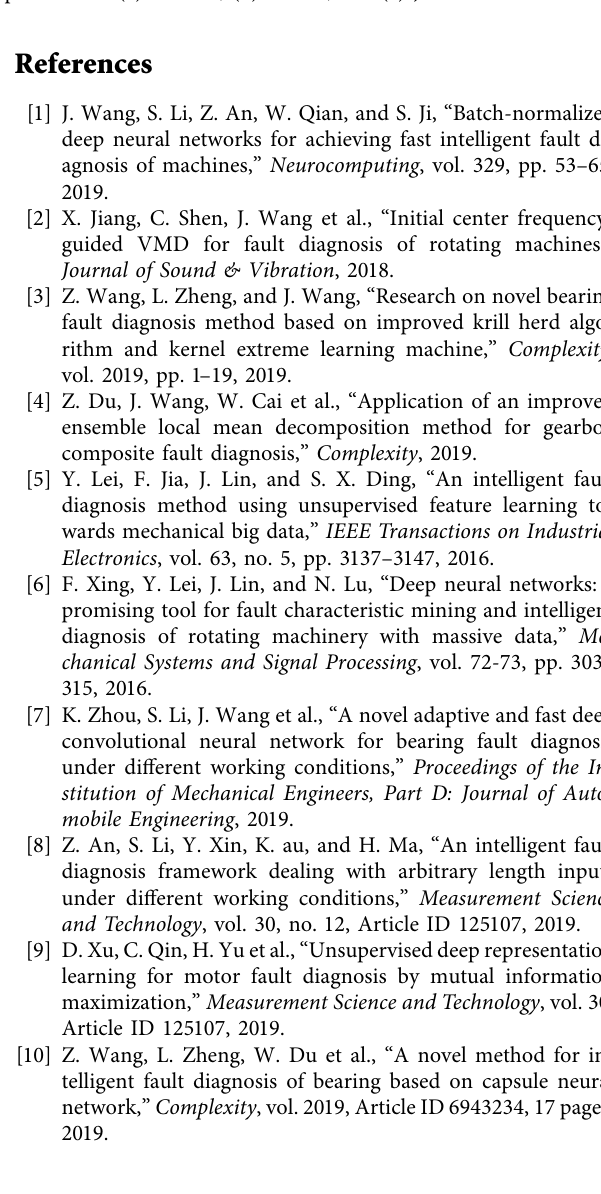
Figure 9: Scatter diagram for transfer scenarios in Experiment 3: (a) G ⟶ H, (b) I ⟶ H, and (c) J ⟶